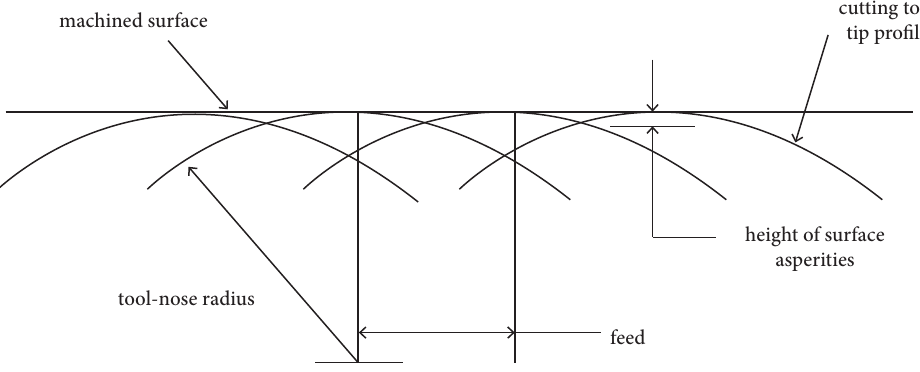
Figure 3. An illustration of the influence of insert nose radius ( n